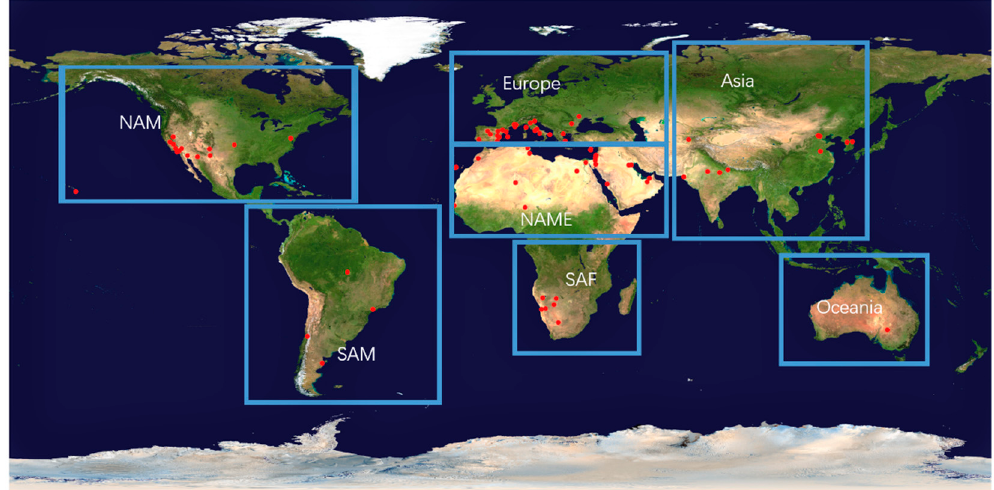
Figure 18. Geographical boundaries of the seven regions defined for the aerosol parameter analysis. AERONET sites are indicated by the red dots.